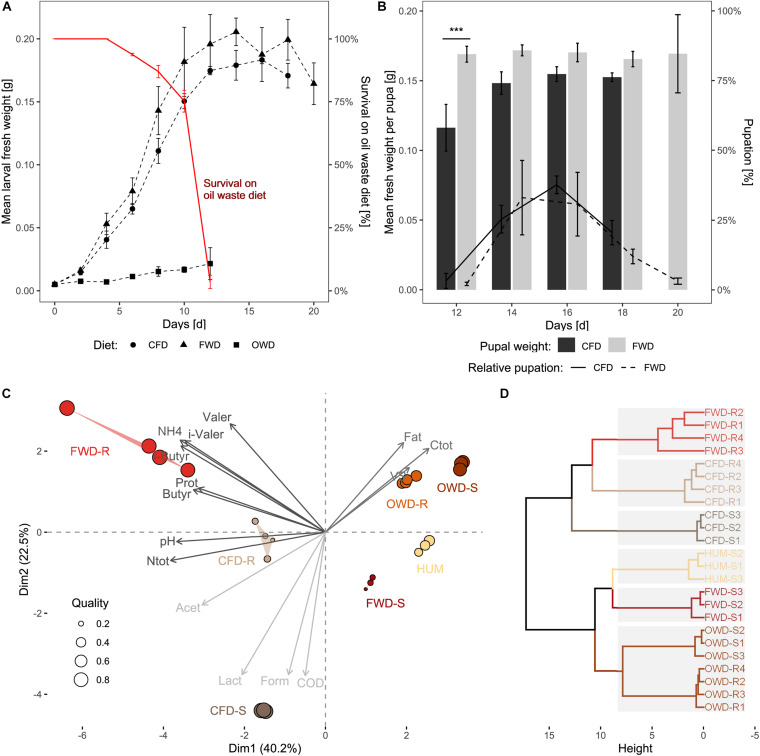
Performance of black soldier fly larvae, pupae, and their three diets. (A) Dotted lines represent the impact of diet on the increase of larval fresh weight (n = 4). The red line highlights the survival of larvae on OWD. (B) Bars indicate the fresh weight of pupae in relation to their time of harvest. The lines show the fraction of larvae that transitioned to pupal stage in each sampling time point. Larvae fed with OWD did not reach pupal stage and are not shown in the graph (n = 4). (C) Principal component analysis based on physicochemical properties of fresh substrates (-S) and substrate residues (-R). The three clusters of variables represented by the arrows were determined by k-means clustering and are distinguished by different shades of gray (fresh: n = 3; residues: n = 4). (D) Hierarchical clustering of sample replicates. Gray backgrounds represent sample clusters determined by the gap statistics method. CFD, chicken feed diet; FWD, food waste diet; OWD, oil waste diet; HUM = pine humus; Prot, proteins; Ntot, total nitrogen; Ctot, total carbon; VS, volatile solids; COD, chemical oxygen demand; (i-)Valer, (i-)valerate; (i-)Butyr, i-butyrate; Form, formate; Lact, lactate; Acet, acetate. ***p < 0.001.